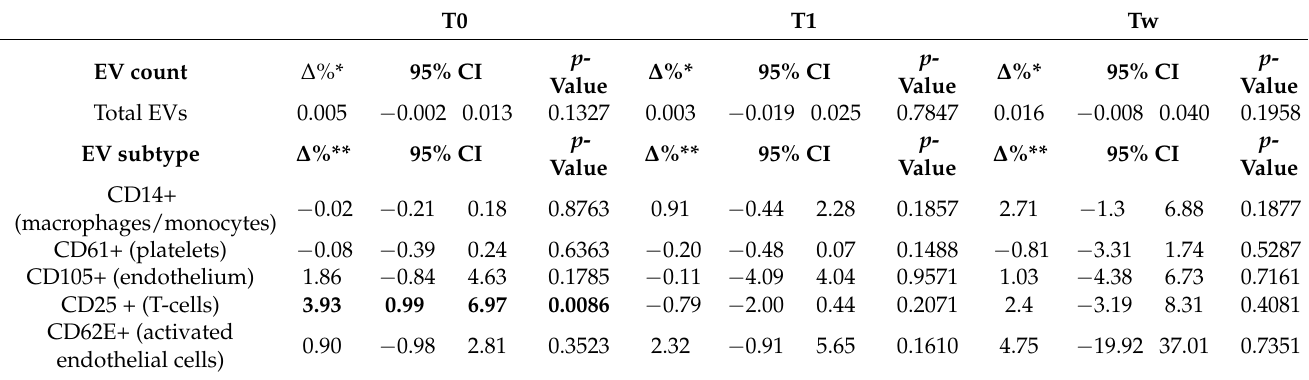
Table 3. Relationships between National Institute of Health Stroke Scale (NIHSS) one week after the acute event and count of EV and EV subtype at T0, T1, and Tw. T0 T1 Tw